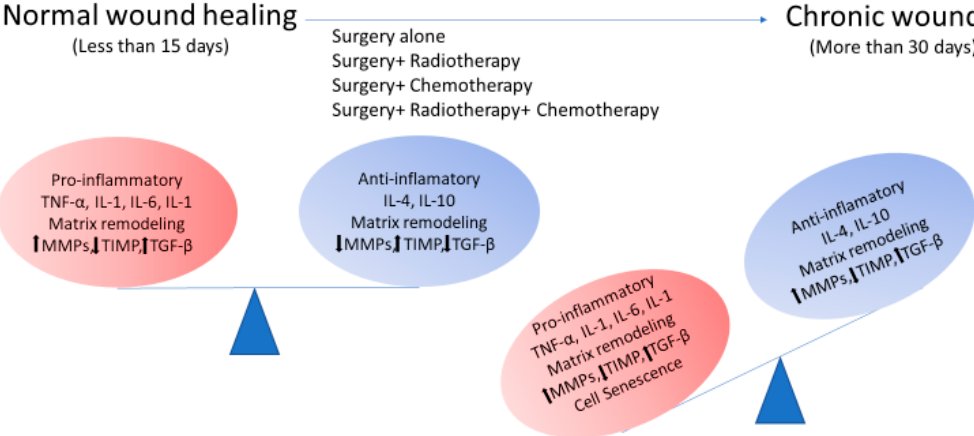
Figure 2. Chronic inflammation is the key feature in the radiogenic wound. In normal wound healing, there is a balance between the production of pro-inflammatory and anti-inflammatory cytokines, which is shifted towards a prolonged inflammatory phase in the radiogenic wound. Later, in the remodeling phase, there is an imbalance in the synthesis of matrix metalloproteinases (MMPs) and their tissue inhibitor (TIMP) in radiated skin.